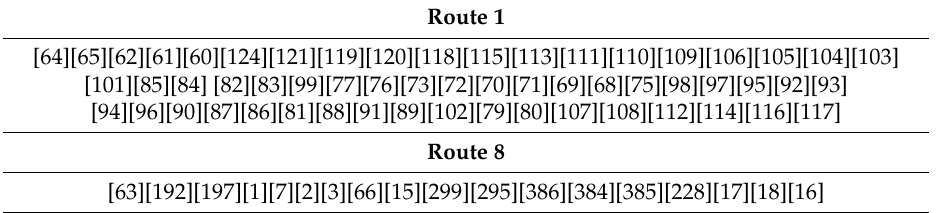
Table 6. The modified route order for retail stores delivered in the first route and the last route based on PRIRPSDR.